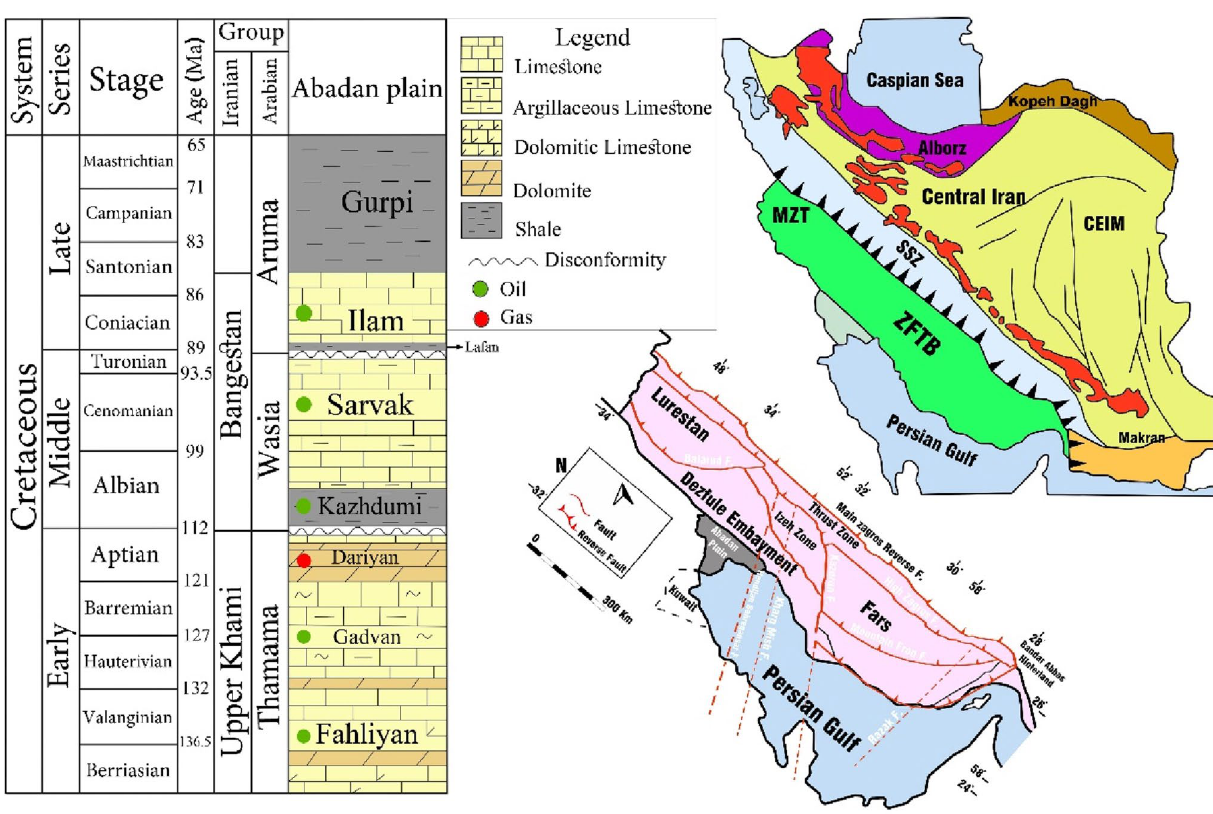
Fig. 1 Zagros structural divisions and stratigraphy column of Abadan Plane